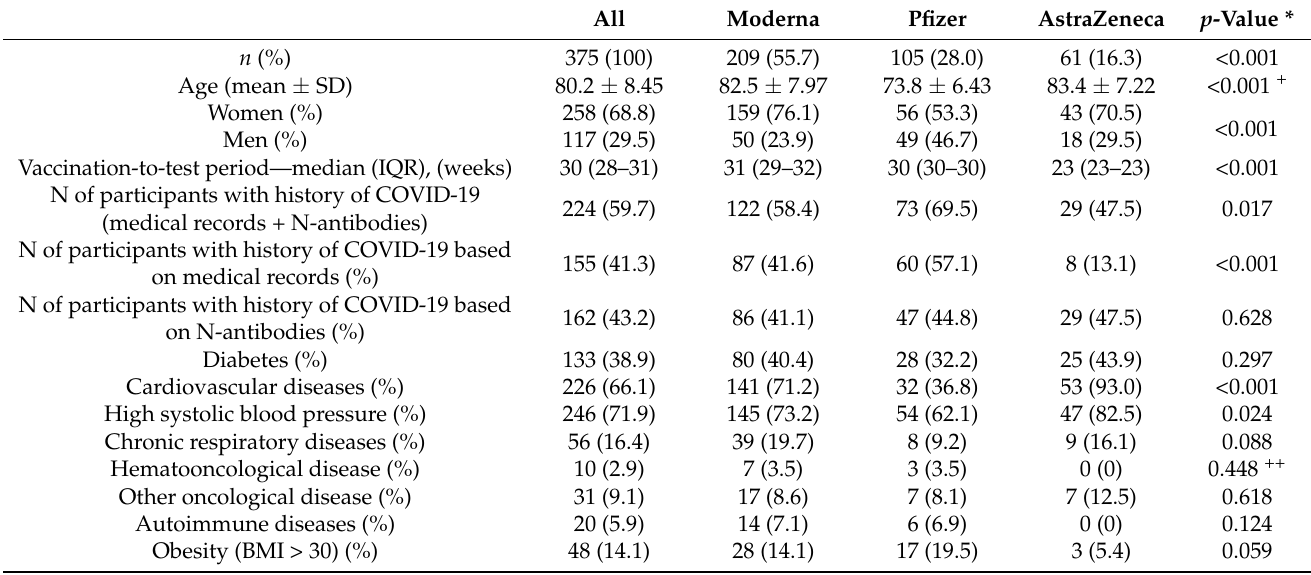
Table 1. Description of individual groups.